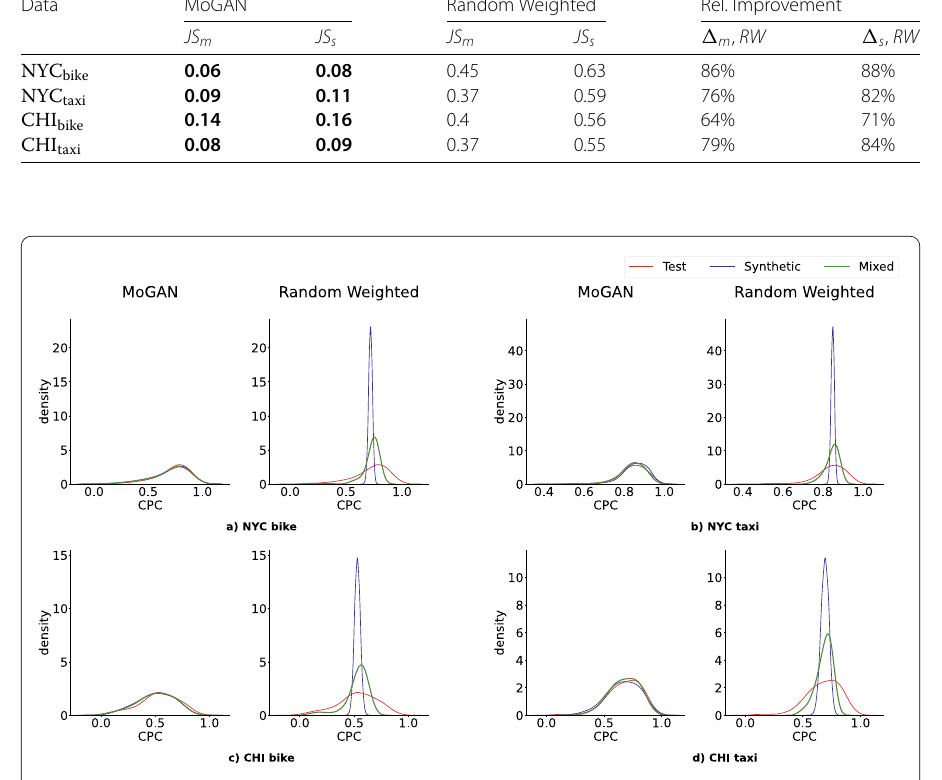
Figure 5 Results for the CPC with Random Weighted Model. Distributions of the pairwise CPC distances between mobility networks in the test set (red), synthetic set (blue), and mixed set (green), for the four datasets. For each dataset, we compare the overlap of the distributions of MoGAN and the Random Weighted model. MoGAN distributions are perfectly overlapping, while the Random Weighted ones show significant